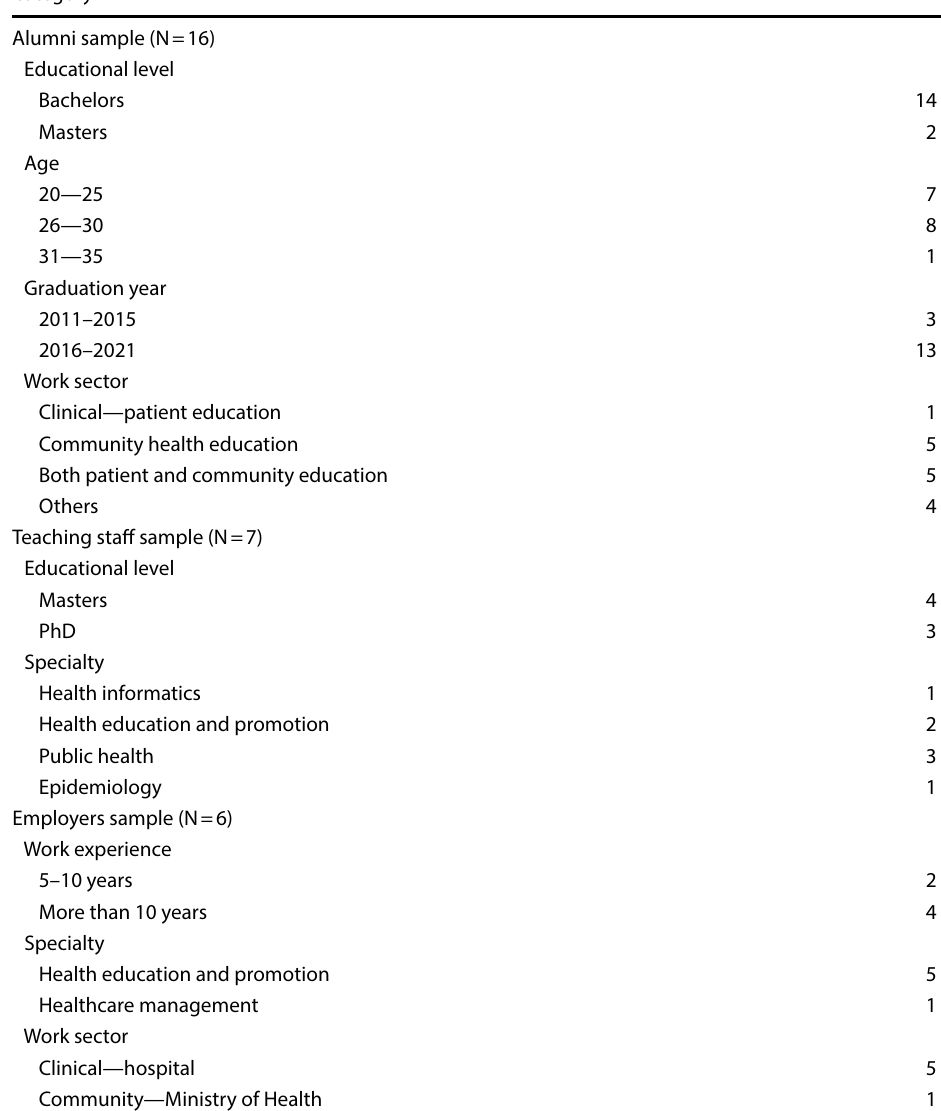
Table 1 Characteristics of the study